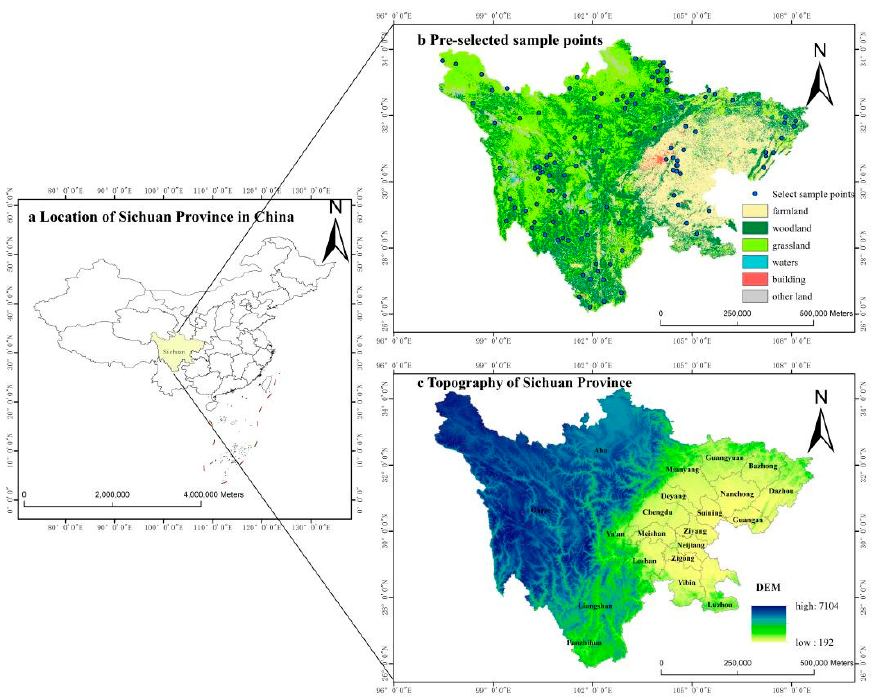
Figure 1. Study area land type zoning and selection sample points.